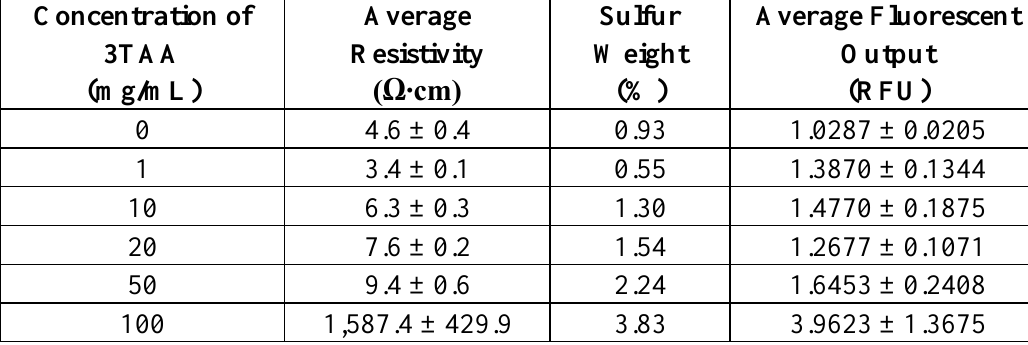
Table 1. Characterization of polypyrrole copolymer with increasing concentrations of 3-thiopheneacetic acid (3TAA) (resistivity and fluorescent output are averages ± the standard error of the mean). RFU: relative fluorescence